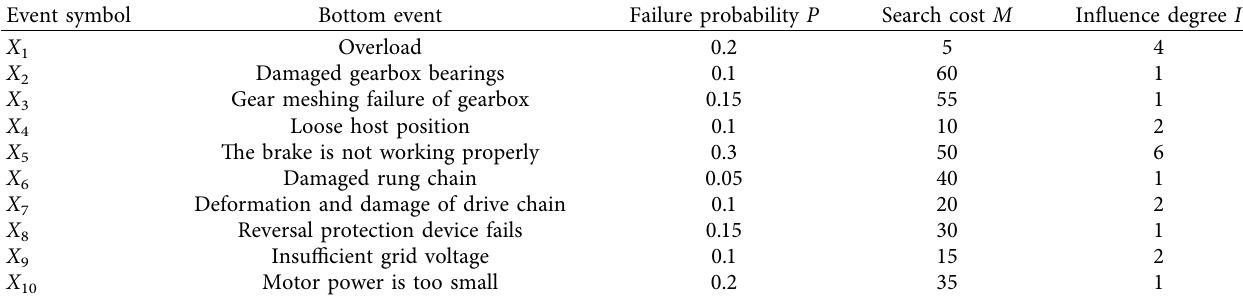
Table 3: Ranking table of failure probability, search cost, and influence degree.